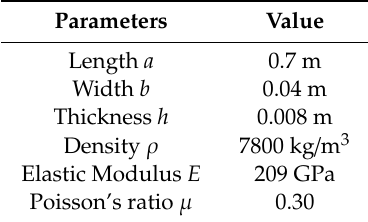
Table 5. Parameter table of simply supported beam.